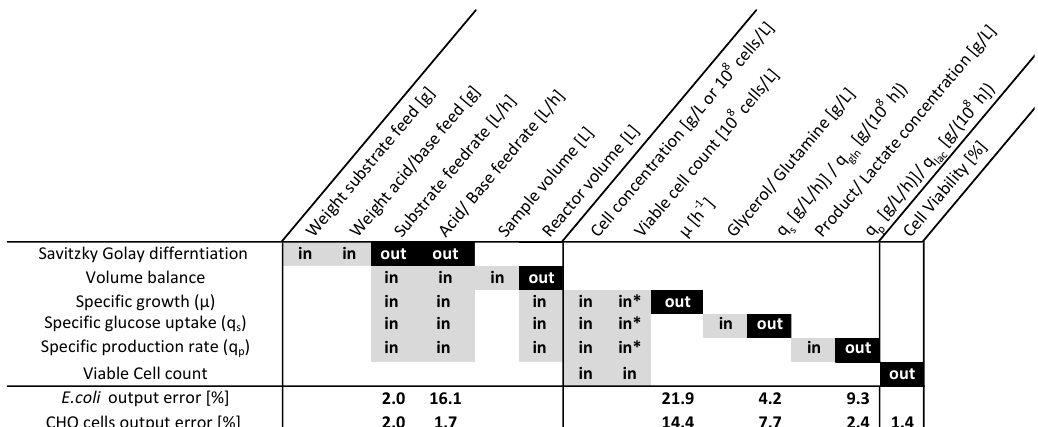
Figure 2. Rate calculation procedure for E. coli and CHO cell cultivation datasets, presenting the inputs (in) and outputs (out) of the single calculation steps and the relative average error for the outputs obtained by a Monte Carlo error propagation. The target variables for the subsequent analysis were the specific growth rate ( µ ), the cell-specific glycerol ( q s ) and glutamine ( q Gln ) uptake rates, the recombinant protein ( q p ) and lactate ( q ( Lac ) ) formation rates, and the cell viability. * The viable cell count was used as an additional input for the CHO cell